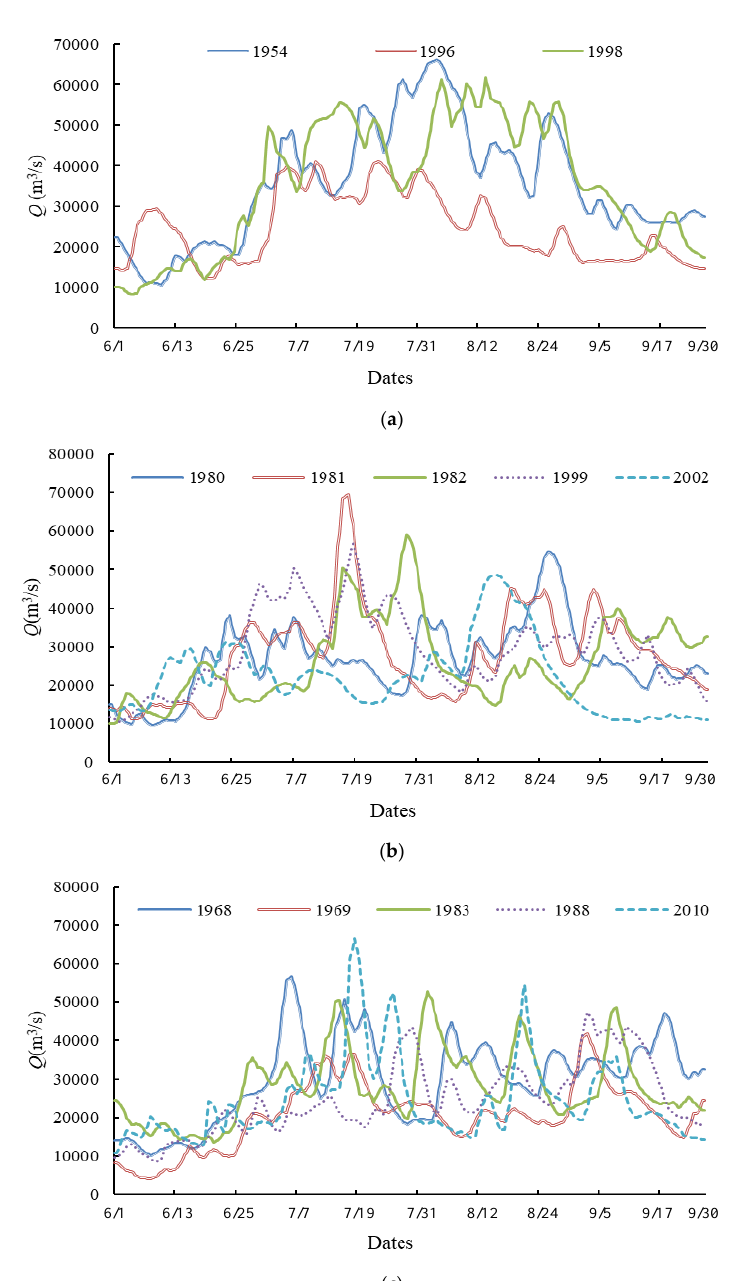
Figure 4. All the typical flood hydrographs (THFs) used in this study. ( a ) Observed flood hydrographs of the years 1954, 1996, and 1998; ( b ) observed flood hydrographs of the years 1980, 1981, 1982, 1999 and 2002; ( c ) observed flood hydrographs of the years 1968, 1969, 1983, 1988 and